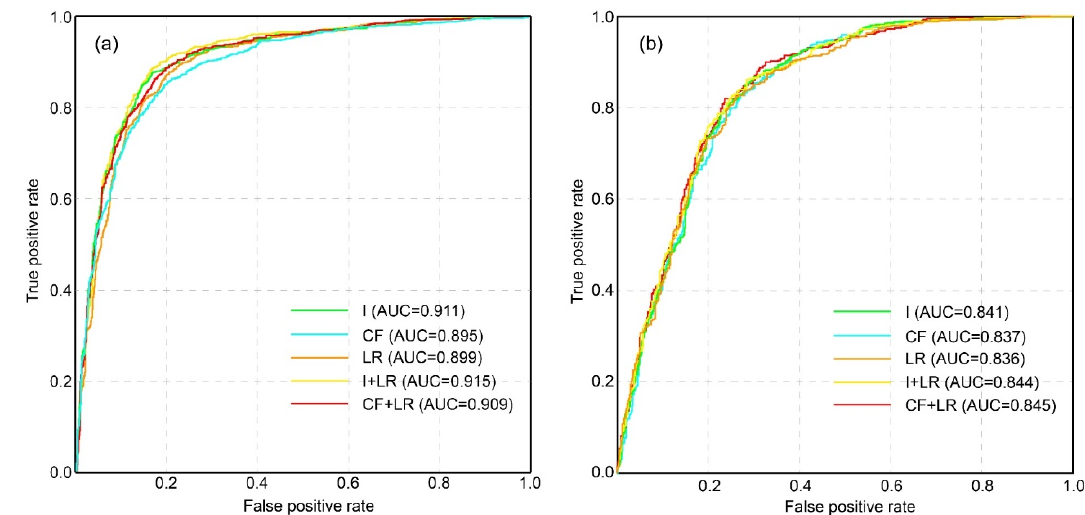
Figure 10. ROC curve. ( a ) Jiuzhaigou earthquake landslide susceptibility; ( b ) Minxian earthquake landslide susceptibility.